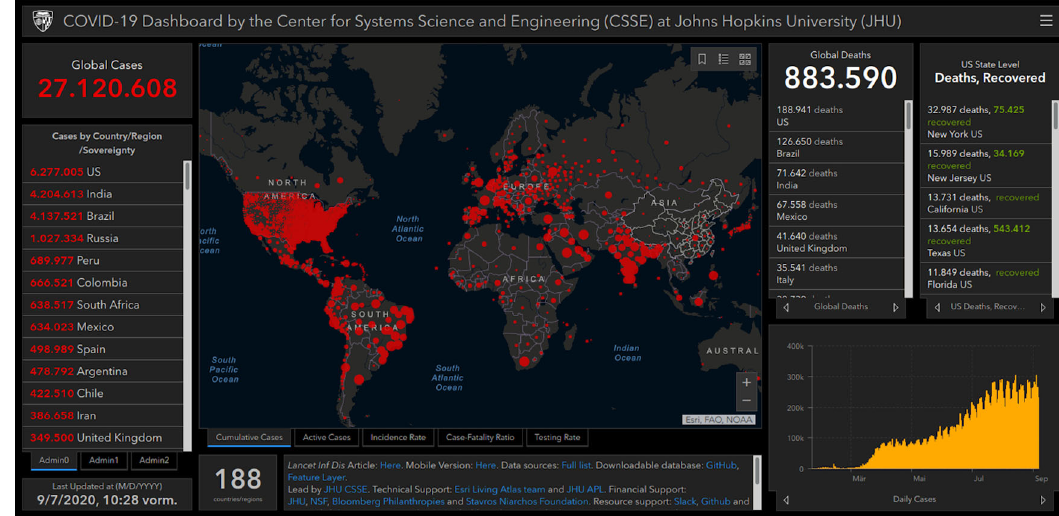
Figure 1. Coronavirus COVID-19 global cases by the Center for Systems Science and Engineering (CSSE) at Johns Hopkins University